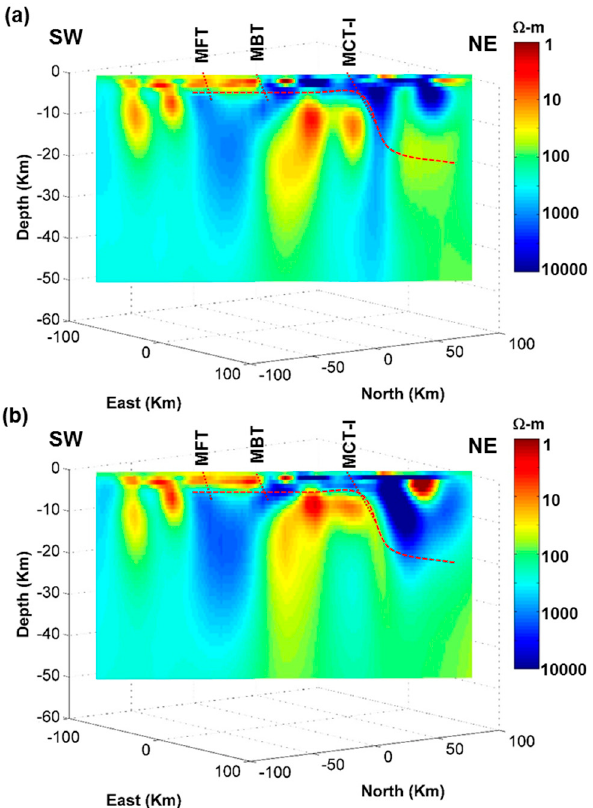
Figure 14. The vertical section of 3D-inverted model along the profile: ( a ) topographically distorted data and ( b ) topographically corrected data; red-dashed line shows the flat–ramp–flat geometry of the Main Himalayan Thrust (MHT).